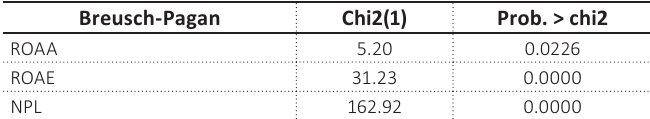
Table A3. Heteroskedasticity –